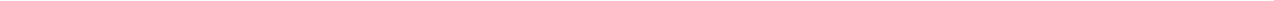
Fig. 1 Mip-GAL4 neurons switch the mating decision. a The experimental procedure used for the behaviour assays. Female fl ies were incubated at the indicated temperatures for 30 min prior to the mating or re-mating assays. For the re-mating assay, females were mated individually with naive CS males and kept at 23 °C for 48 h before being paired with a second naive CS male. b – e Mating frequencies of virgin females of the indicated genotypes, scored as the percentage of females that copulate within 1 h. f – i Re-mating frequencies of mated females. j – l Ovipositor extrusions per minute observed in virgin females j , l or mated females k paired with naive CS males j , k , males of the indicated genotype or no male l . m Mating frequencies of virgin females of the indicated genotypes injected with 12 pmol of sex peptide (SP) in saline or saline alone 2 h prior to the assay. The numbers in parentheses represent n . NS indicates non-signi fi cance ( P > 0.05); *** P < 0.001 for comparisons against both controls (grey bars); Chi-square test b – i , m or one-way ANOVA with Tukey ’ s multiple comparison test j – l . Error bars in j – l indicate